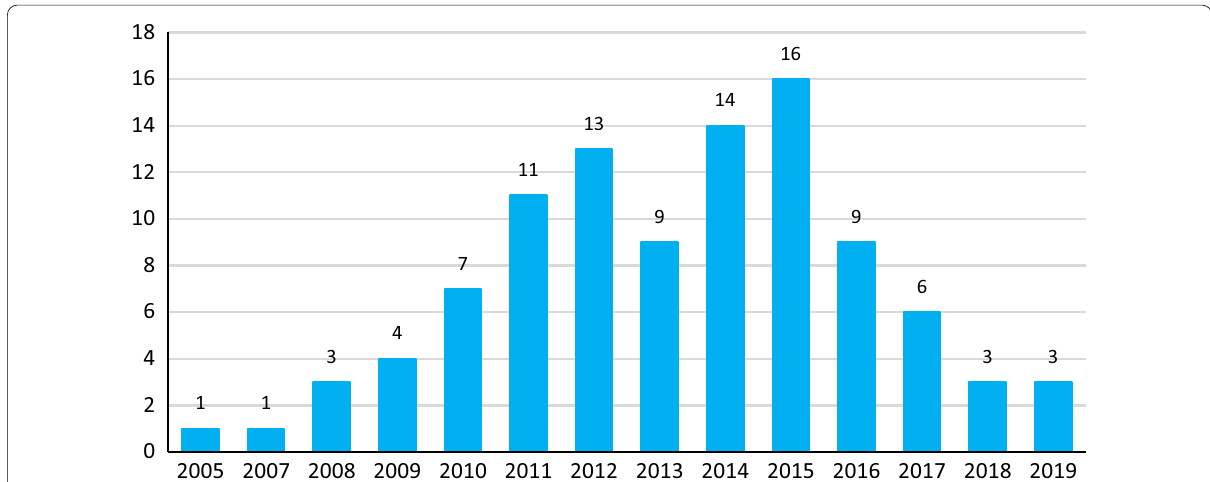
Fig. 2 Distribution of the top 100 most-cited empirical research publications over the years (Note: all 100 of these most-cited publications were published in the years